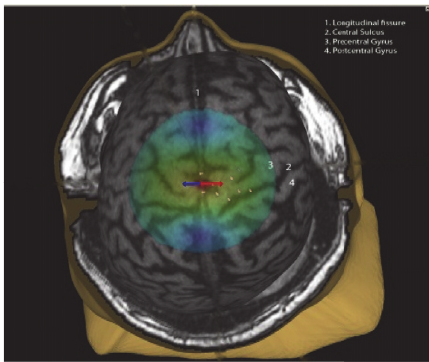
Figure 1: Example image obtained during stimulation of the paretic lower extremity cortical